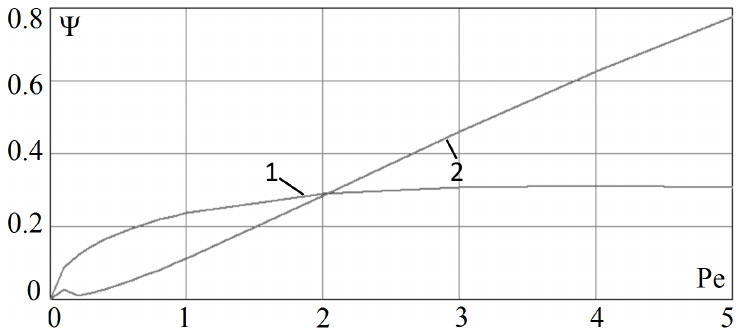
Figure 13. Error functions Ψ of the numerical solution of the test problem IV in the norm L 1 depending on values of grid Péclet number: 1—the scheme (47), 2—the scheme